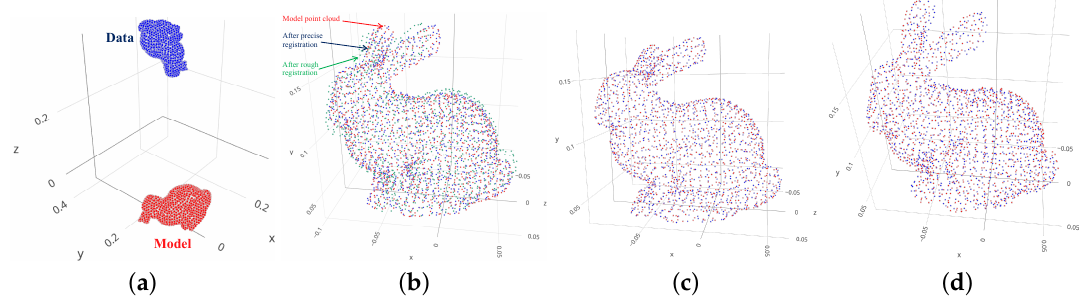
Figure 12. The registration results of Bunny data for test sample 6: ( a ) The initial state; ( b ) 3-D CNNs then 2-D CNNs, ( c ) RANSAC then ICP, ( d ) Fast Global Registration.